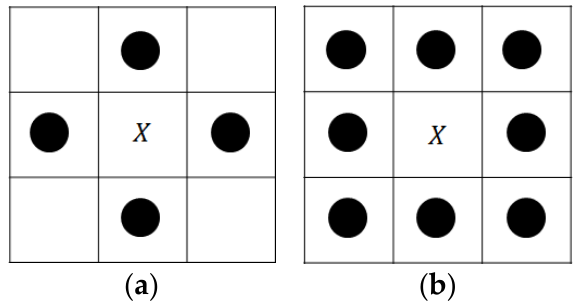
Figure 5. ( a ) 4-Connected and ( b ) 8-connected area labeling.